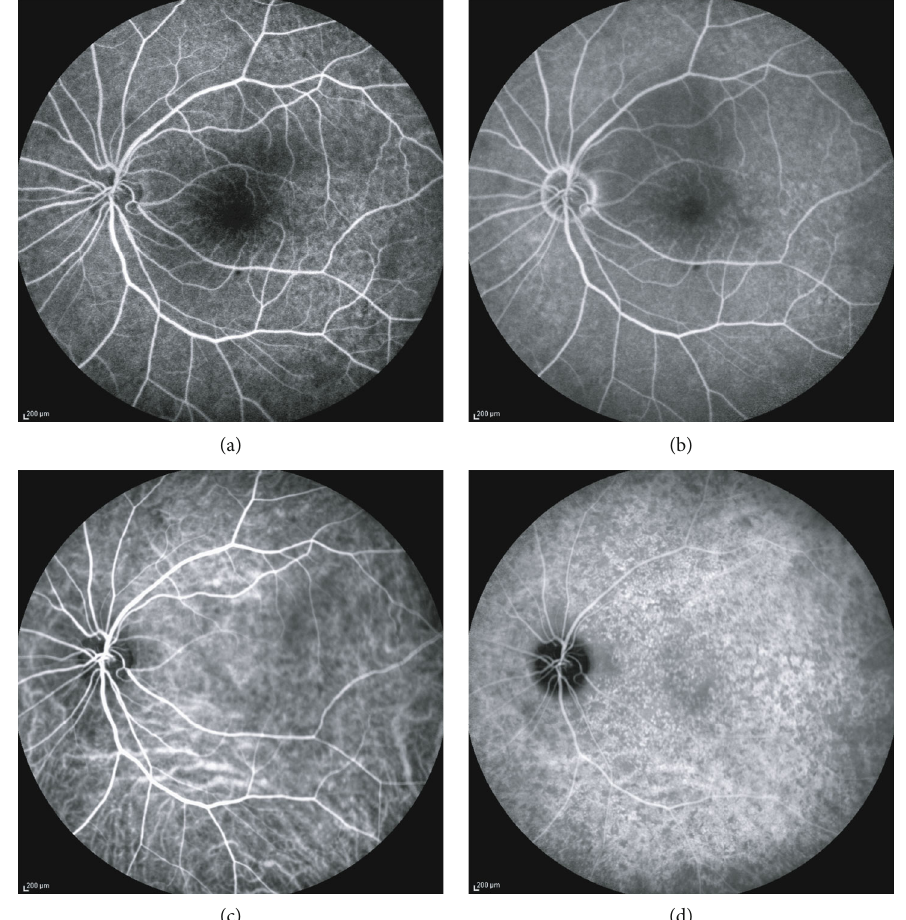
Figure 3: Fluorescein angiograms of the early (a) and late (b) phases in the left eye. Indocyanine green angiograms of the early (c) and late (d) phases in the left eye.